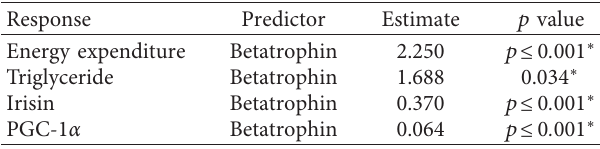
Table 3: Univariate linear regression analysis.